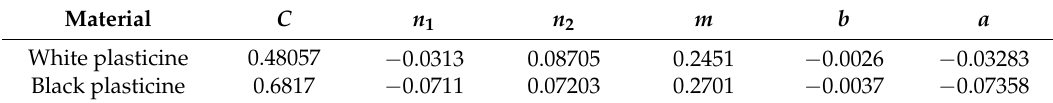
Table 1. Constant of the white and black plasticine material